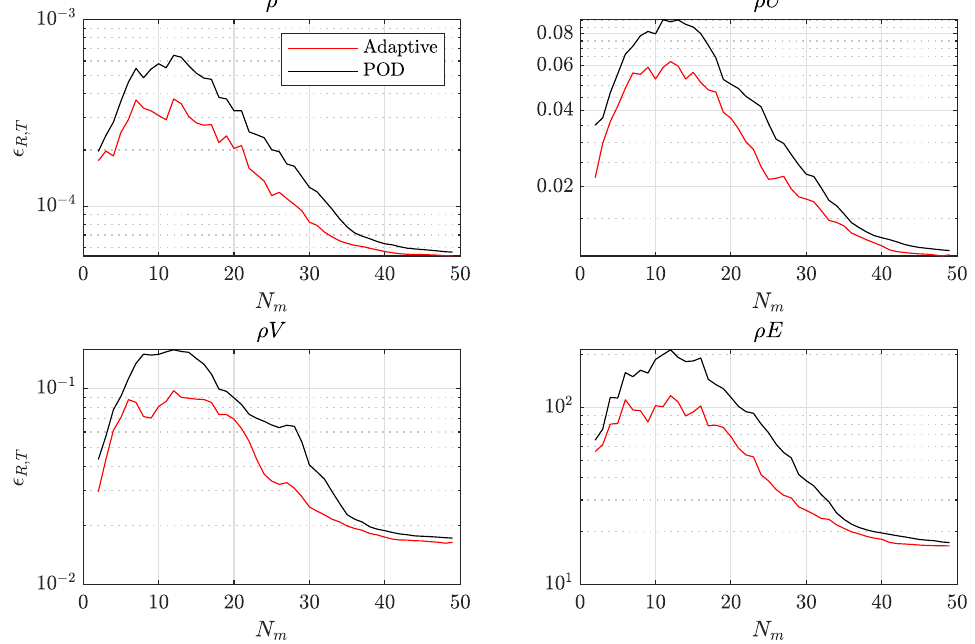
Figure 7. The log 10 ( (cid:101) R,T ) varying the number of modes, for adaptive ROM and POD, 30P30N test